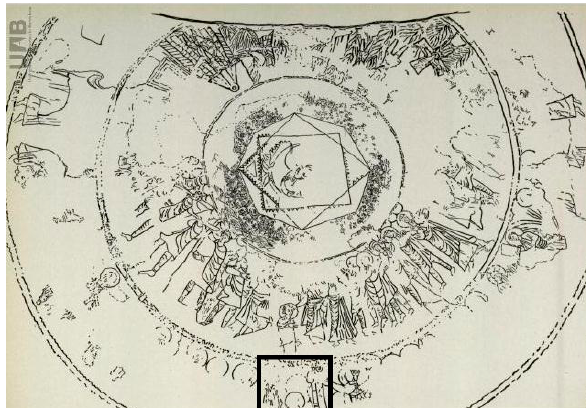
Figure 27. Santa Maria de Terrassa, wall paintings. © author.